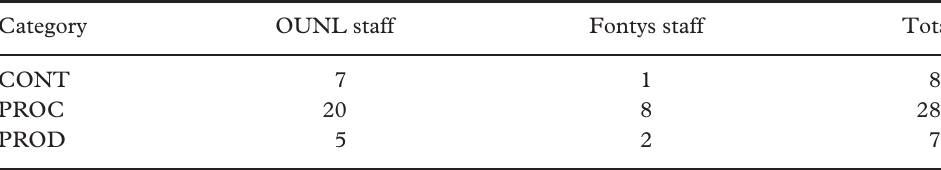
Table 3. Critical situations categorised: absolute frequencies of items for the categories